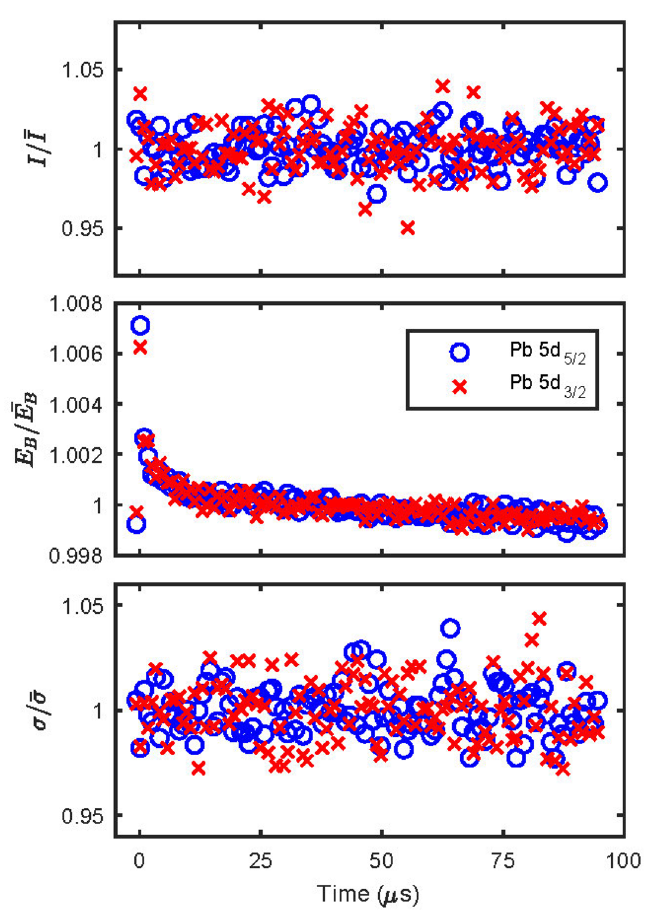
Figure 6. Fit parameters of the trigger time map shown in Fig. 5: top—intensity (I), middle—position (E B ), bottom—width ( σ ). The parameters for the Pb 5d 5/2 and Pb 5d 3/2 are normalized to their arithmetic mean values over the whole trigger time